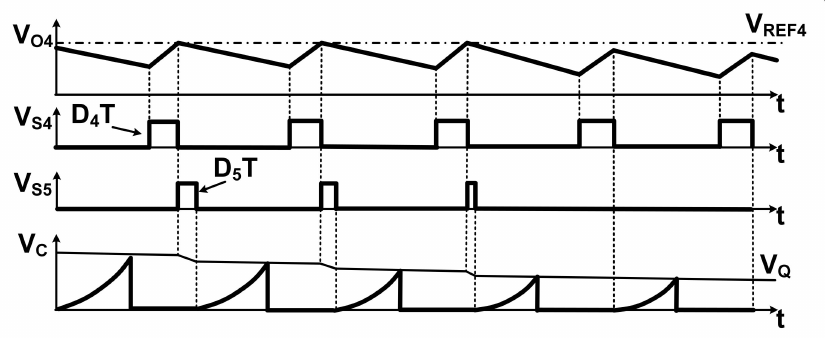
Figure 6. Timing diagram for high-to-low load